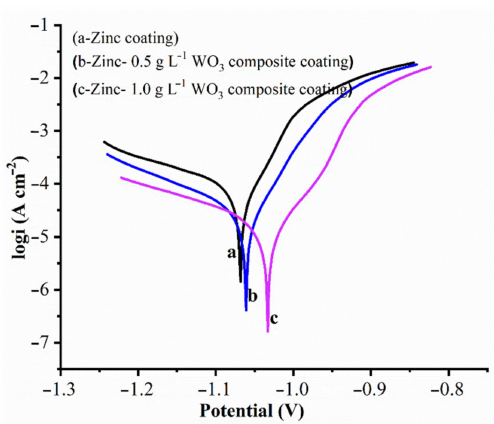
Figure 10. Tafel curves of Zn and Zn–WO 3 composite coatings in 3.5% NaCl